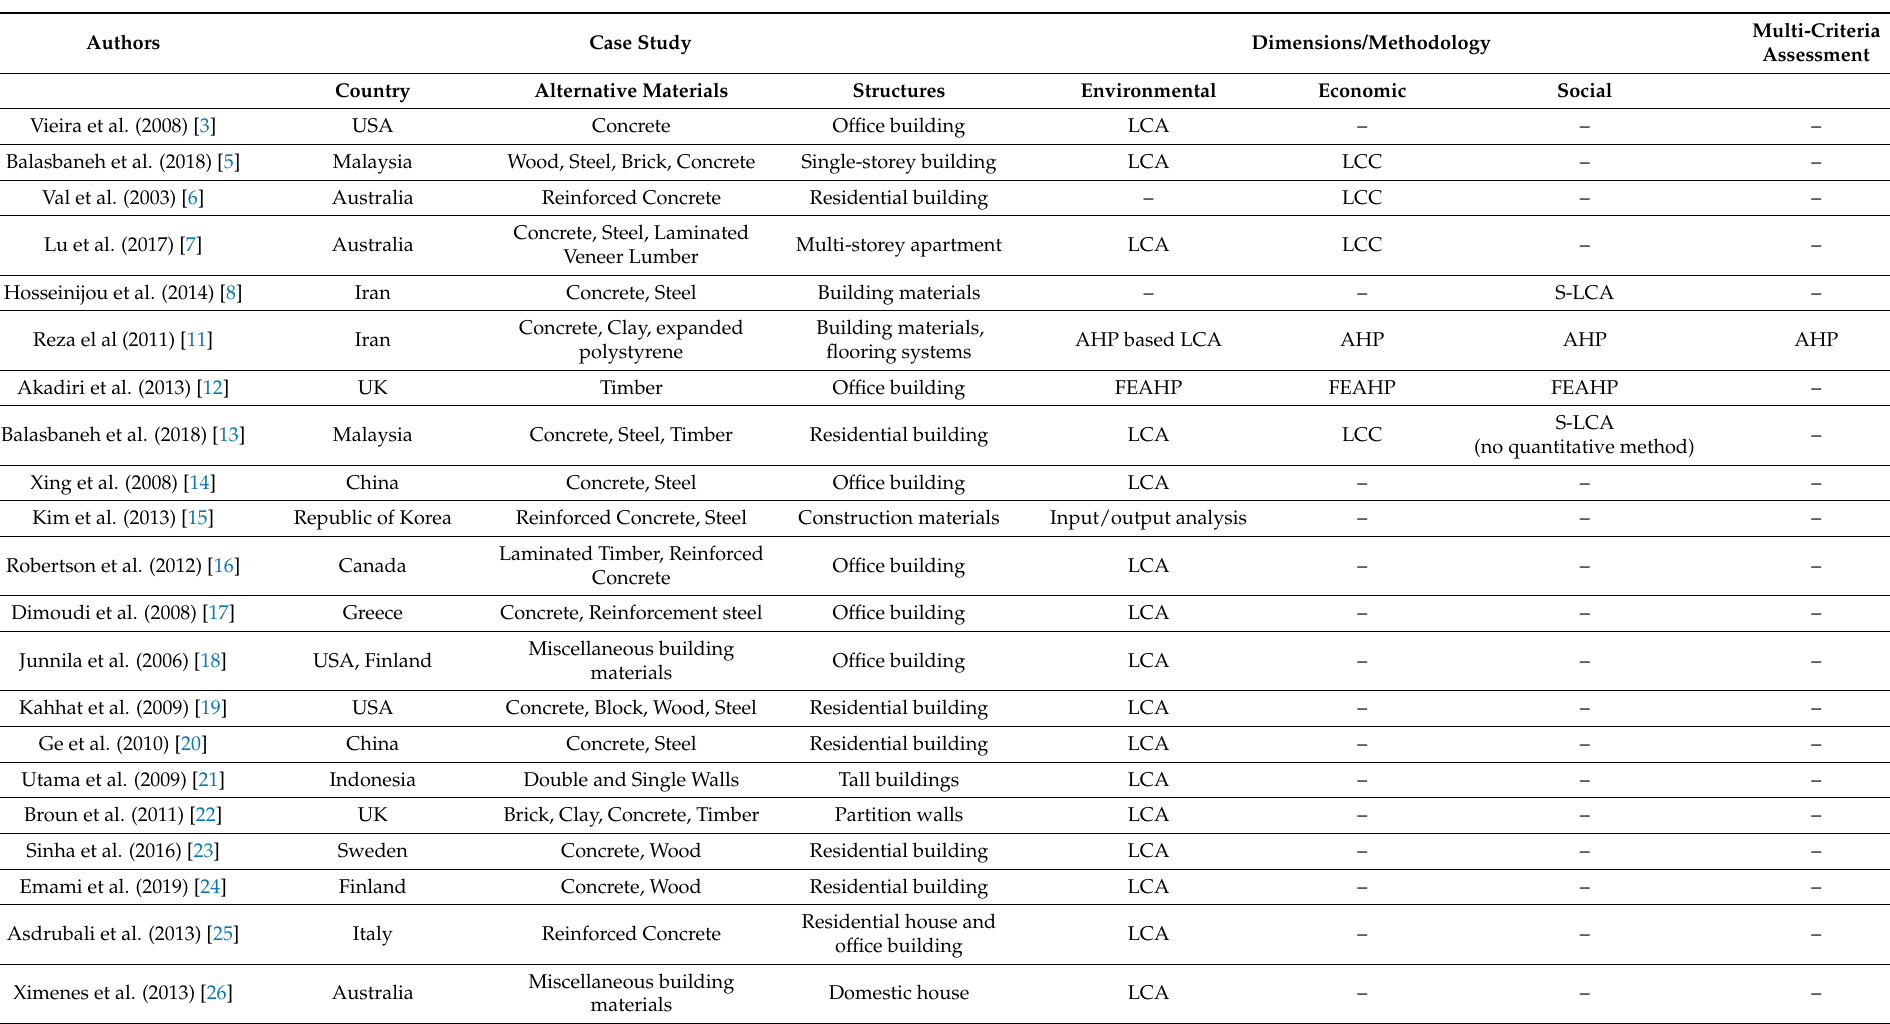
Table 1. Comparison of this research with most relevant